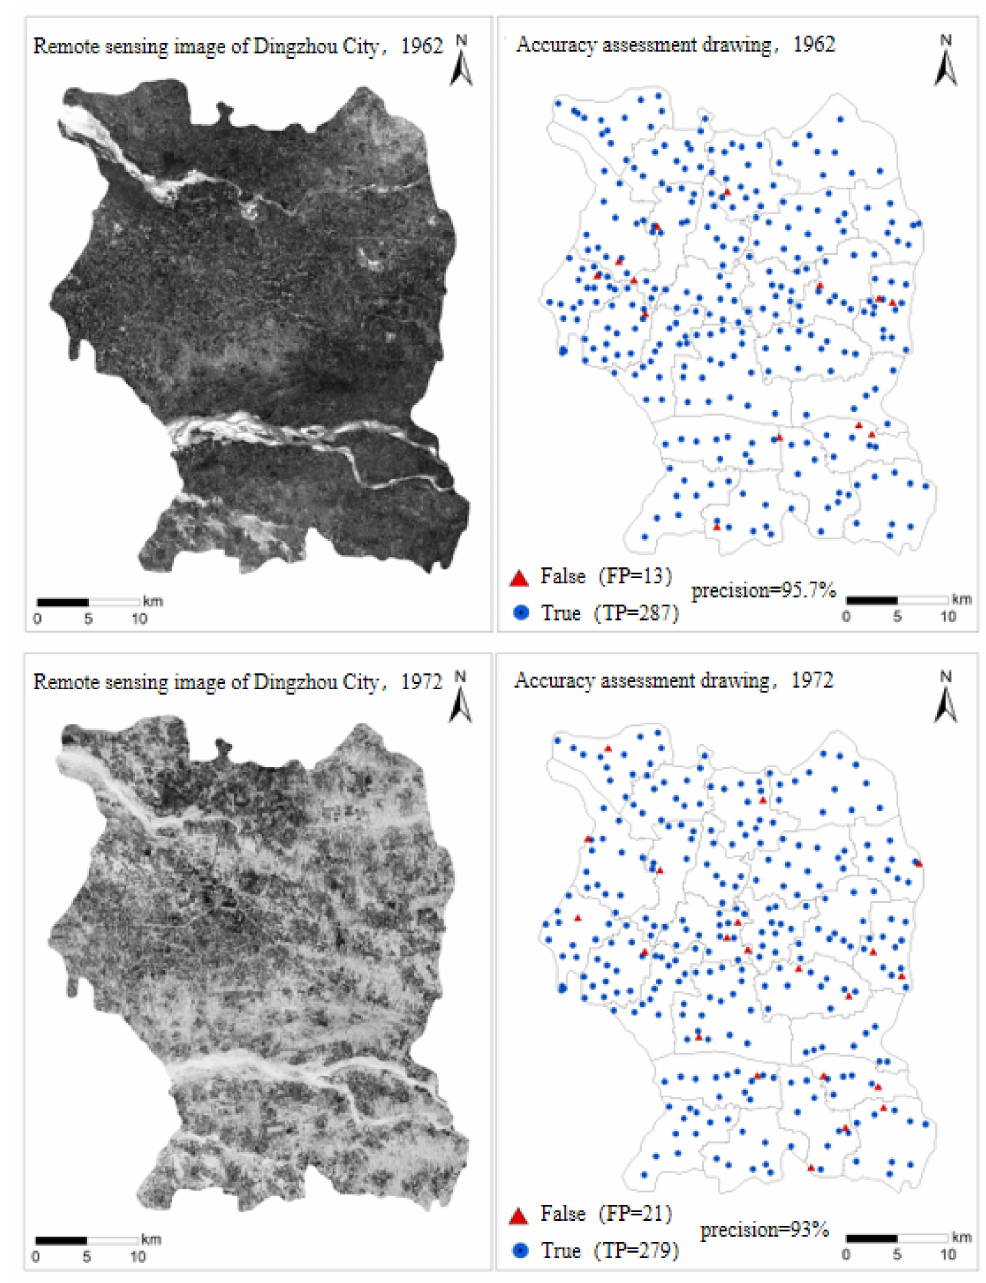
Figure 4. Assessment of rural residential accuracy in Dingzhou in 1962 and 1972 (Figure created in Arc GIS 10.5 ESRI, https://www.esri.com (accessed on 20 December